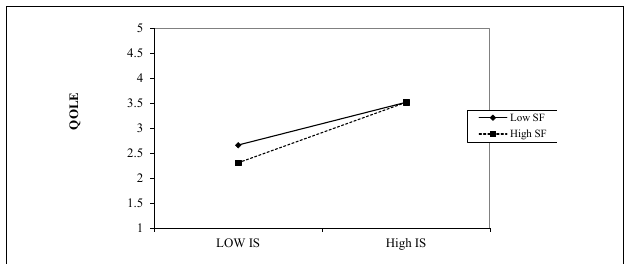
FIGURE 2 | Interaction of situational factors and instructors support.